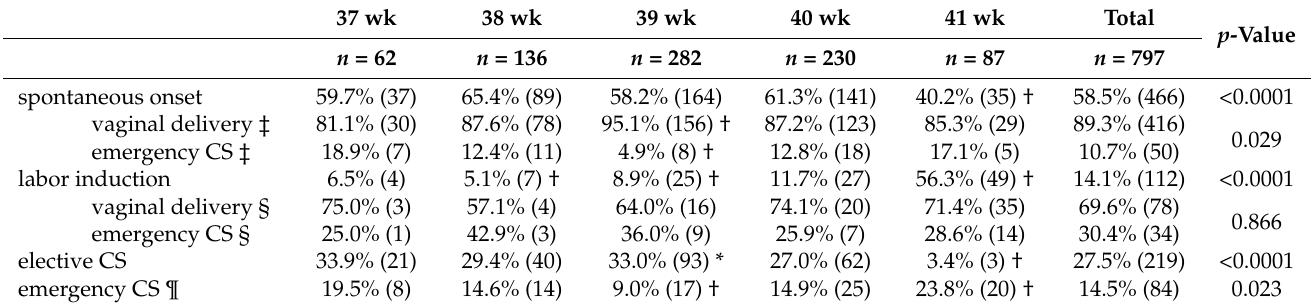
Table 2. Delivery outcomes stratified by gestational